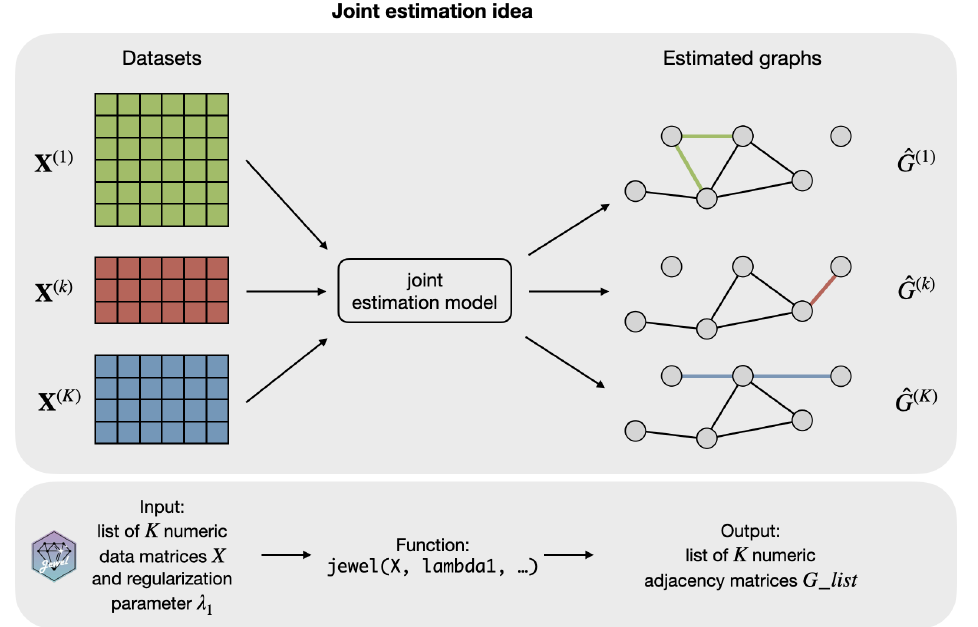
Figure 3. Illustration of how jewel 2.0 estimates the graphs with largely the same support (i.e., the black part of the graphs ˆ G ( k ) ) but also allows for some class-specific edges (colored part of the graphs ˆ G ( k ) ). The lower part of the figure demonstrates how the idea translates to the R package jewel described in Section